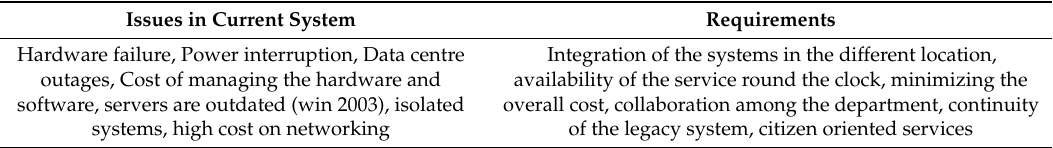
Table 2. Issues in the current system and government requirements.